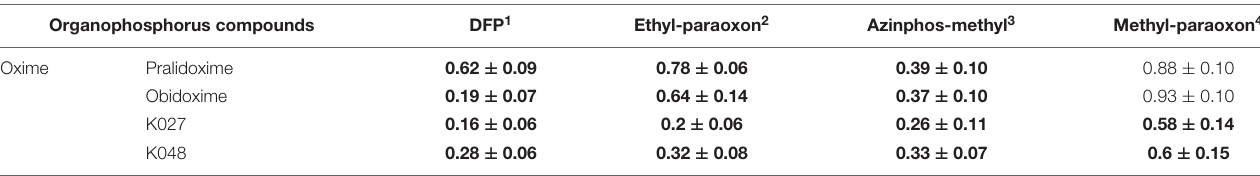
TABLE 4 | Protective efficacy of the tested oximes, assessed by Cox analysis (Cox, 1972) of the cumulative relative risk (RR) of death of animals exposed to the OPCs diisopropylfluorophosphate = DFP, ethyl-paraoxon = paraoxon, azinphos-methyl or methyl-paraoxon and, within 1 min thereafter, treated with the experimental K-oximes (K027, K048) or the established oximes (pralidoxime, obidoxime). Organophosphorus compounds